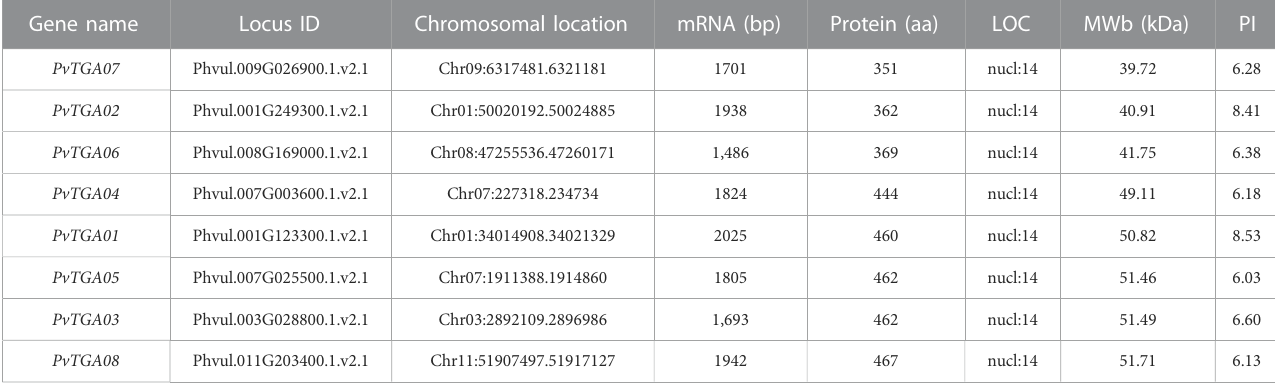
TABLE 1 The genomic and biochemical information for TGA genes identi fi ed in common